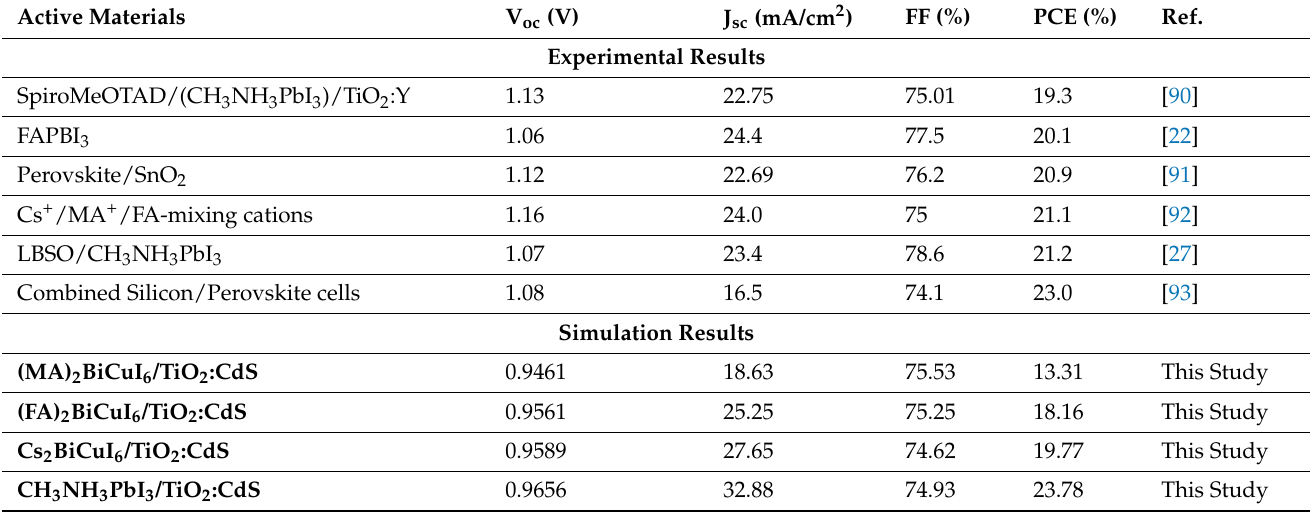
Table 4. Comparison of published work with simulated device designs.